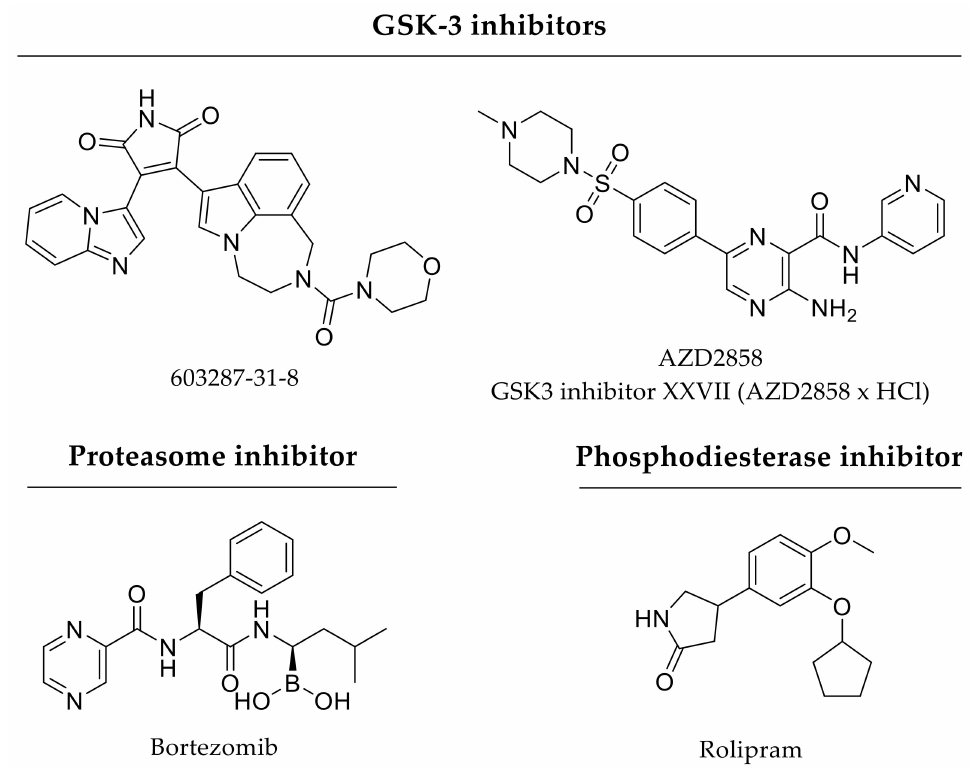
Figure 6. Chemical structure of selected enzyme inhibitors. GSK-3ß is a key enzyme of the Wnt / ß-catenin pathway and inhibition results in cytosolic accumulation of ß-catenin and further transcription of target genes promoting bone formation. Proteasome inhibitor bortezomib, mainly used in treatment of multiple myeloma, hinders proteasomal degradation of ß-catenin leading to the e ff ects mentioned above. Furthermore, phosphodiesterase-4 inhibitors are anti-inflammatory agents and stimulate cellular proliferation as well as di ff erentiation due to accumulated cGMP (cyclic guanosine monophosphate) and protein kinase G-mediated downstream